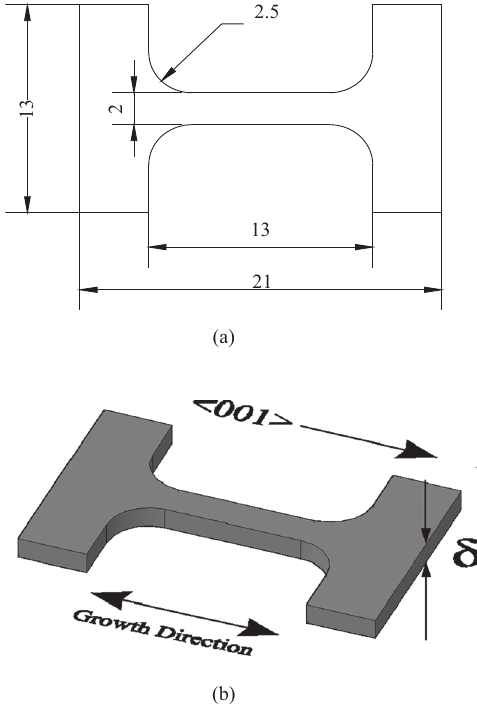
Figure 1: Schematic illustrating the (a) size and (b) shape of the DD6 single-crystal superalloy sheet specimens used in the creep tests.